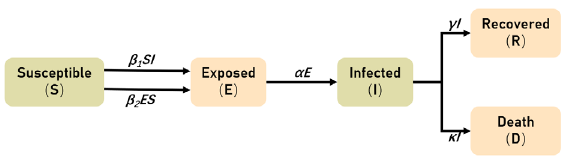
Figure 2. SEIRD model propagation mechanism